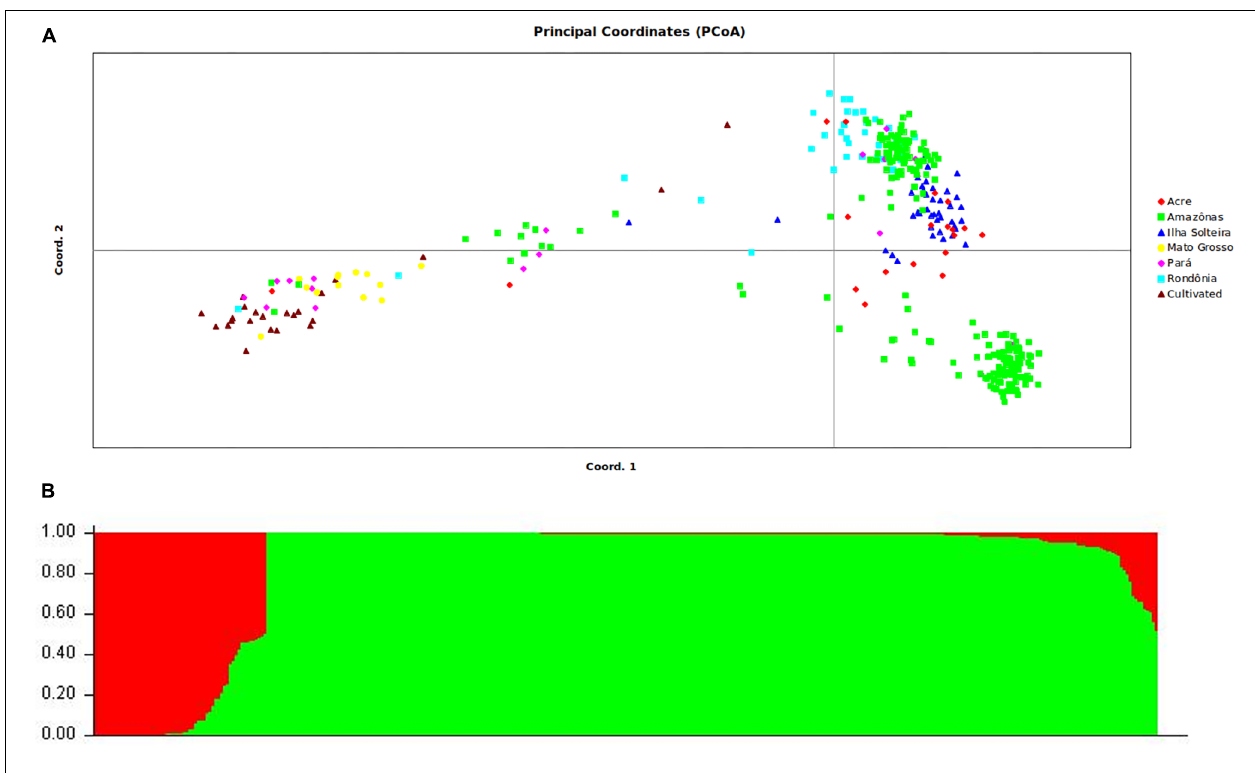
FIGURE 2 | Estimated genetic structure of the wild population and breeding population of rubber tree based on PCoA (A) and STRUCTURE analysis (B) . All analyses are based on the genetic variability of 438 SNP loci.